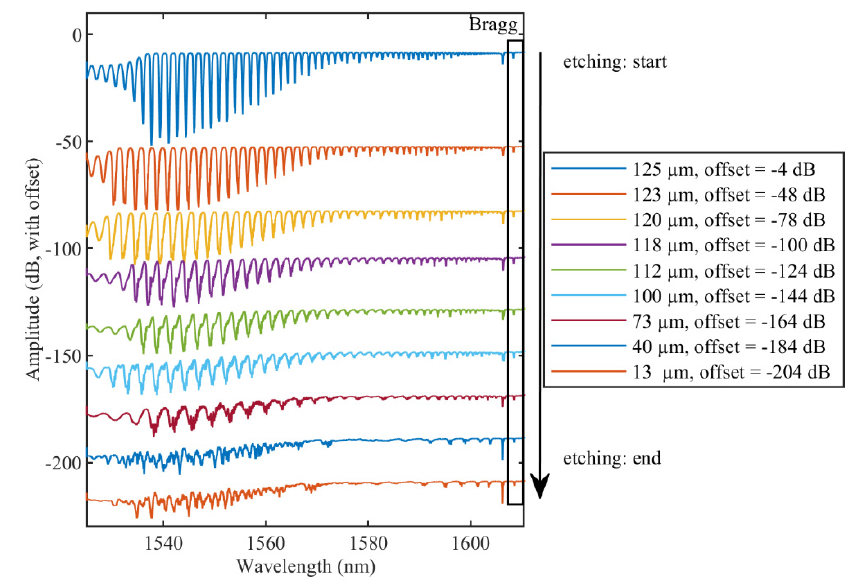
Figure 4. Evolution of TFBG transmission spectrum during the optical fiber etching. Rectangular area shows the Bragg mode of the TFBG. Offset has been introduced for clarity of spectra plotting on one graph.